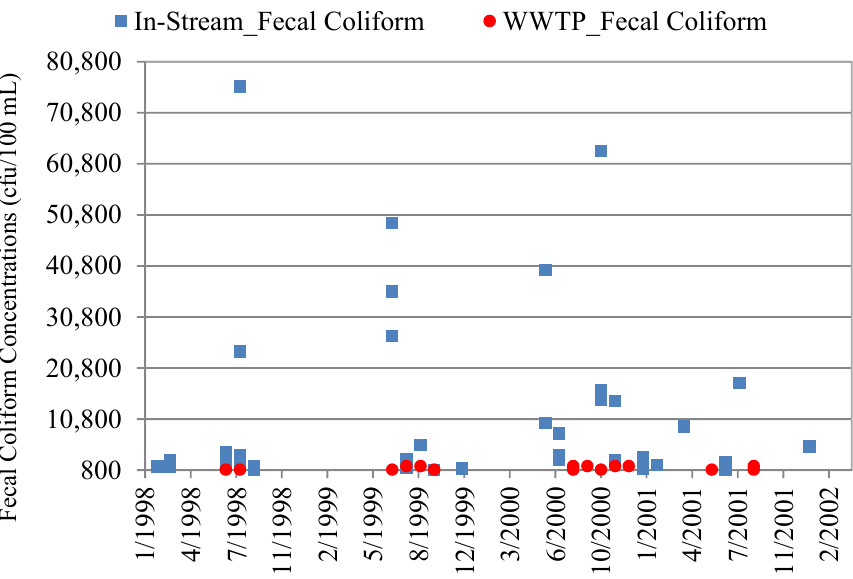
Figure 5. Comparison of fecal coliform maximum WWTP effluent discharge concentrations to in-stream sampling locations. Only values exceeding the 800 cfu/100 mL standard are